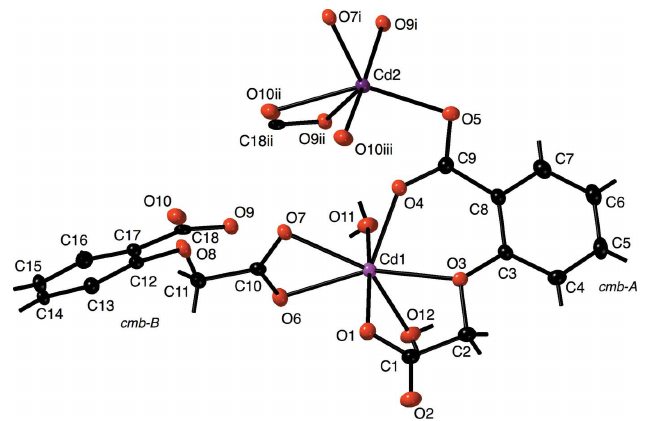
Figure 1 The coordination environments of the title compound, showing the pentagonal bipyramidal coordination at the Cd1 atom and the octahedral coordination at the Cd2 atom. Complete cmb-A and cmb-B ligands are shown. Displacement ellipsoids are drawn at the 50% probability level. Most H atoms have been omitted for clarity. Color code: Cd1, light violet; Cd2, deep purple, N, blue; O, red; C, black. H-atom positions are shown as sticks.